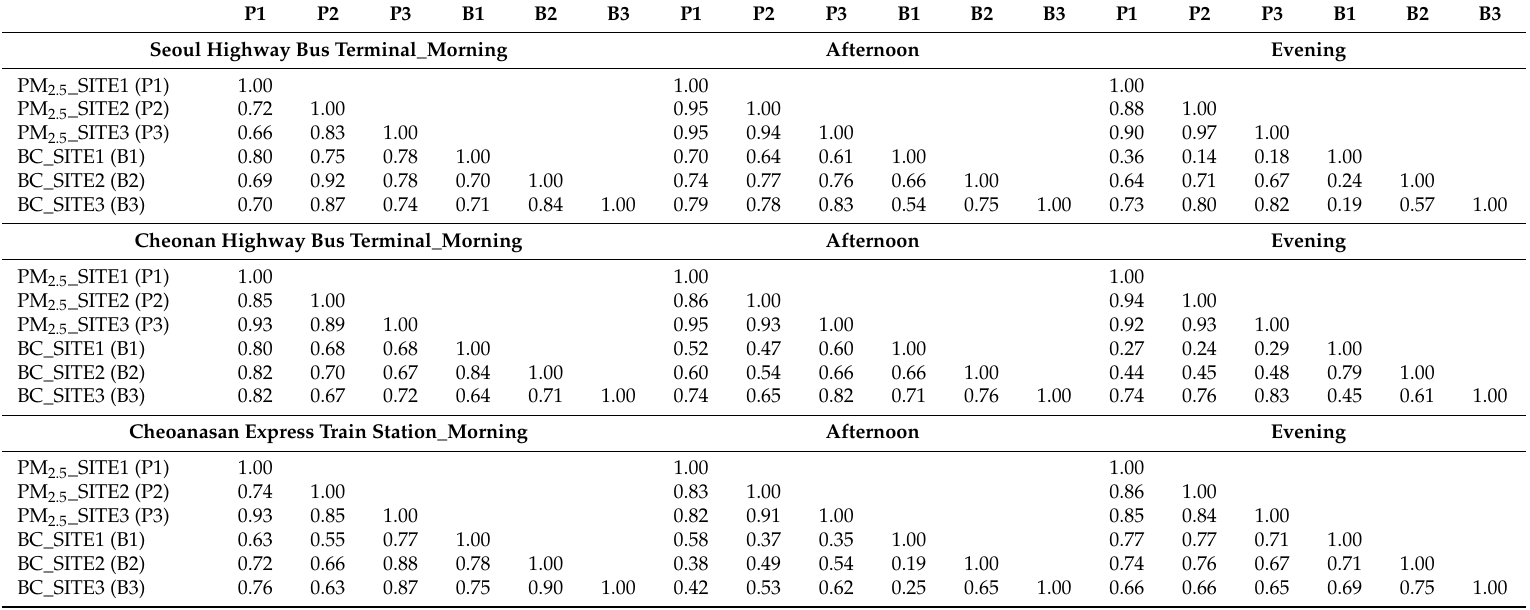
Table A2. Spearman correlation coefficient according to each sampling site and